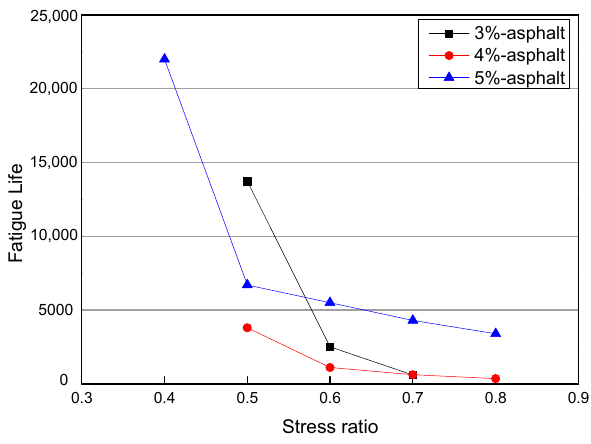
Figure 7. Fatigue times of different asphalt contents.